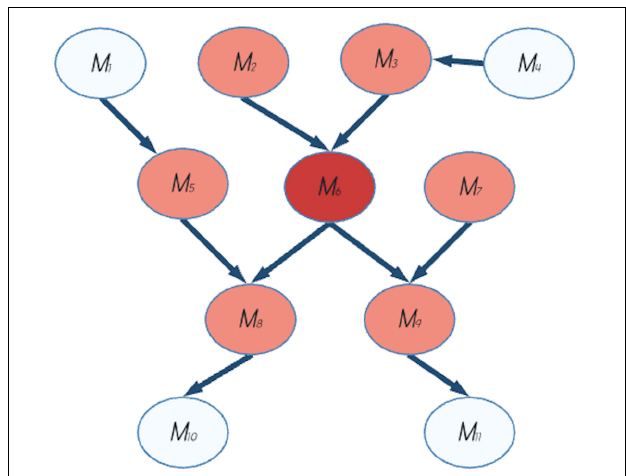
FIGURE 1 | Example of a Markov blanket. The Markov blanket of the node M6 (in red in the figure) comprises the set of parents, children and spouses of the node and it is indicated by the pink nodes. M2 and M3 are the parents, M8 and M9 are children, M5 and M7 are spouses of M6 . The other nodes ( M1, M4, M10, and M11 ) are not in the Markov blanket of M6